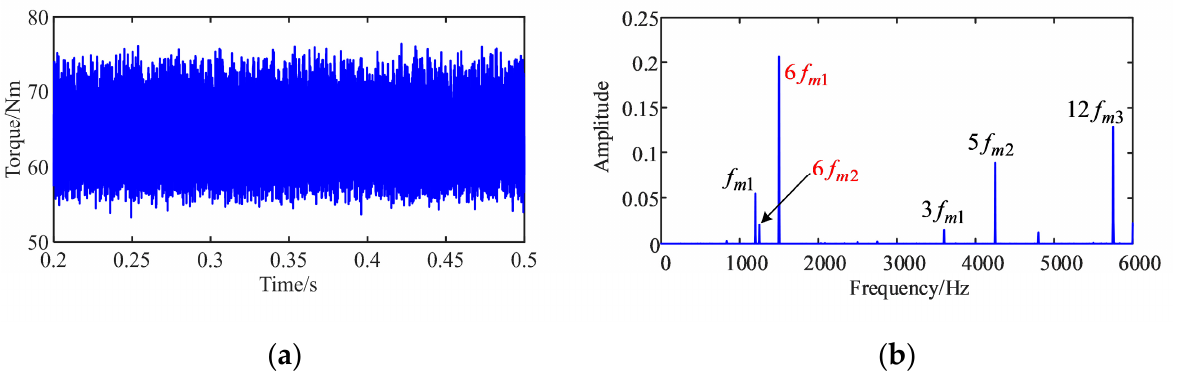
Figure 12. Motor 1’s electromagnetic torque: ( a ) time domain; ( b ) PSD.